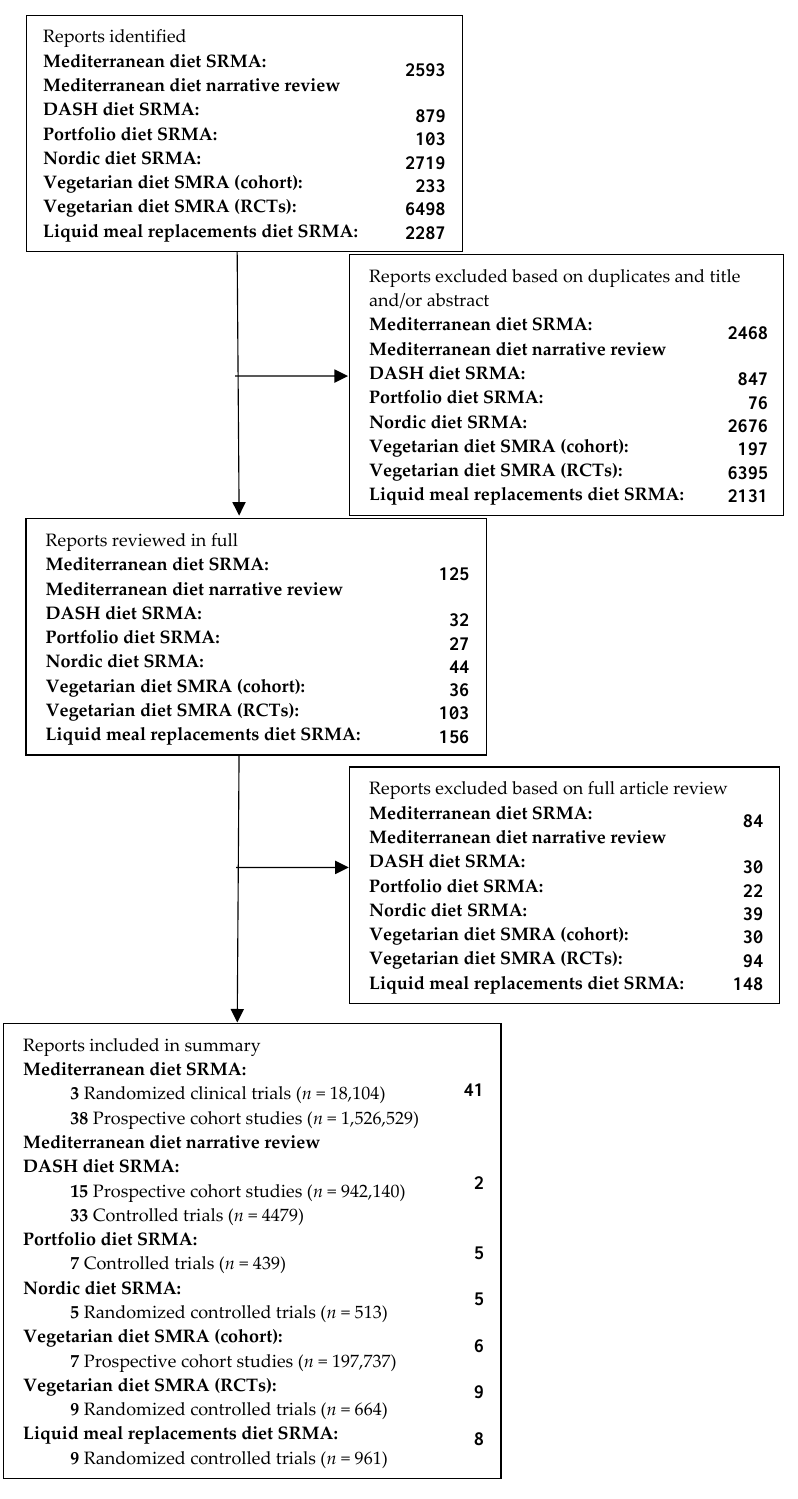
Figure 1. The study selection flow diagram. SRMA: Systematic review and meta-analysis. RCT: Randomized controlled trial. DASH: Dietary Approaches to Stop Hypertension.